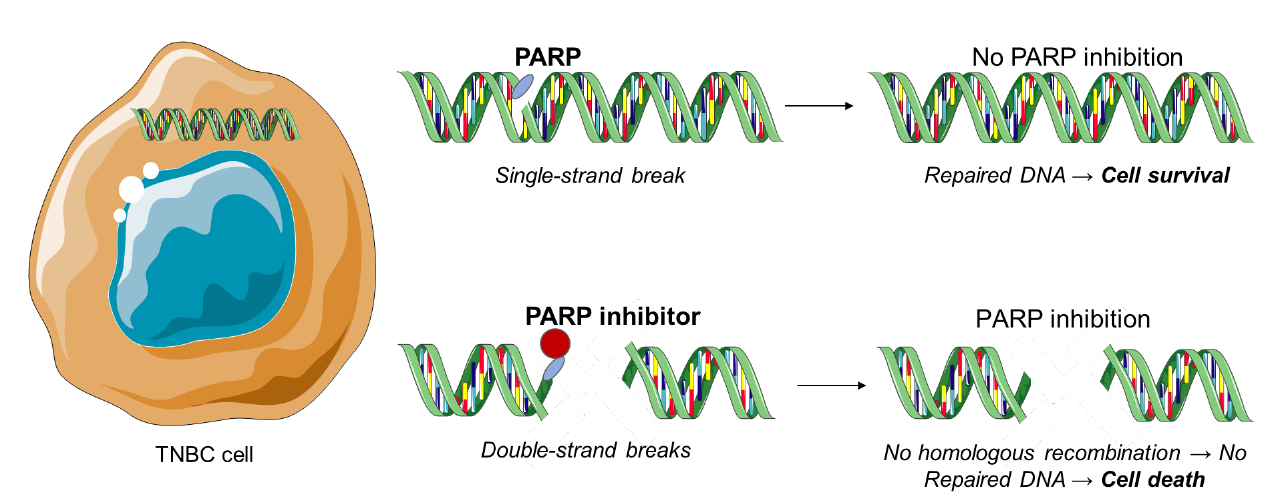
Figure 4. PARP inhibition as a therapeutic strategy against triple-negative breast cancer.